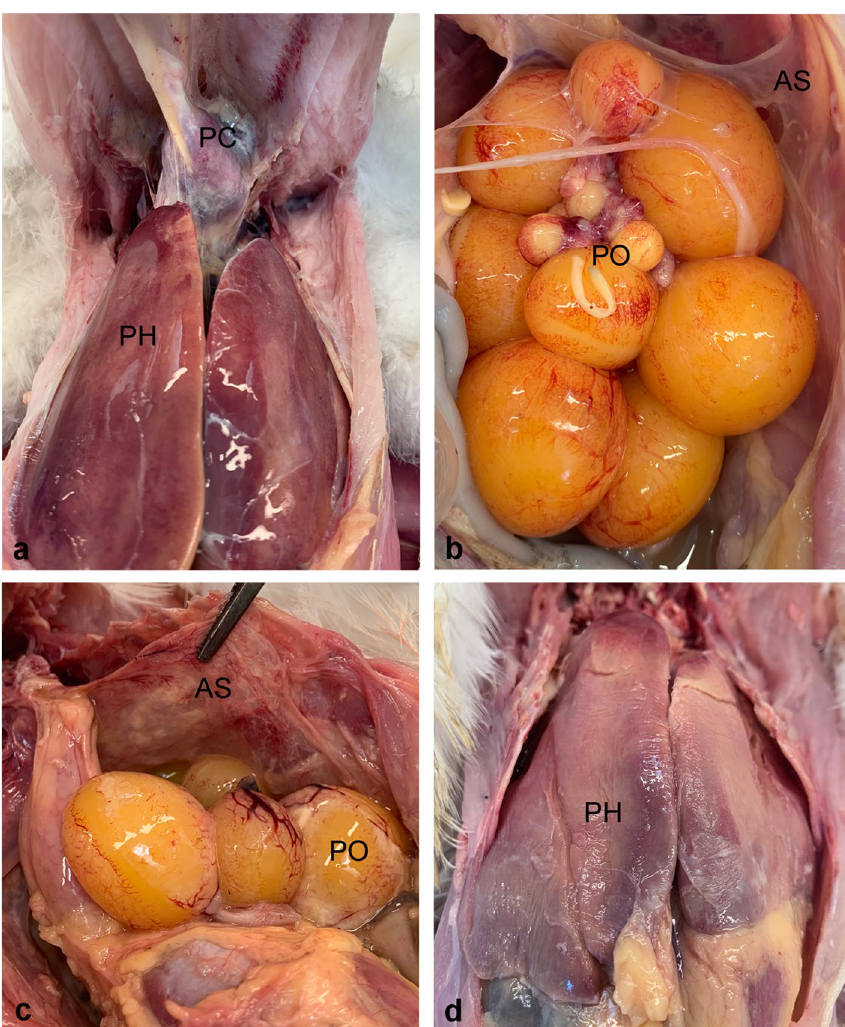
Figure 3. Gross lesions. ( a ) Acute fibrinous perihepatitis (PH) and fibrinopurulent pericarditis (PC) in an Aerosol_1 bird euthanised 2 dpi ( b ) Another Aerosol_1 animal euthanised 2 dpi with multifocal fibrinopurulent perioophoritis (PO). Note the opaque and milky appearance of the remnants of the thoracic air sac (AS). ( c ) A case of severe fibrinopurulent airsacculitis (AS) with prominent hyperaemia and congestion. Note the fibrinopurulent perioophoritis (PO). The bird belonged to the Aerosol_2 group and was euthanised preterm (2 dpi) in accordance with the predefined humane endpoint. ( d ) Liver from the same bird as ( c ) with a fibrinous perihepatitis (PH) and the underlying hepatic parenchyma appearing dry indicating necrosis. dpi days post-